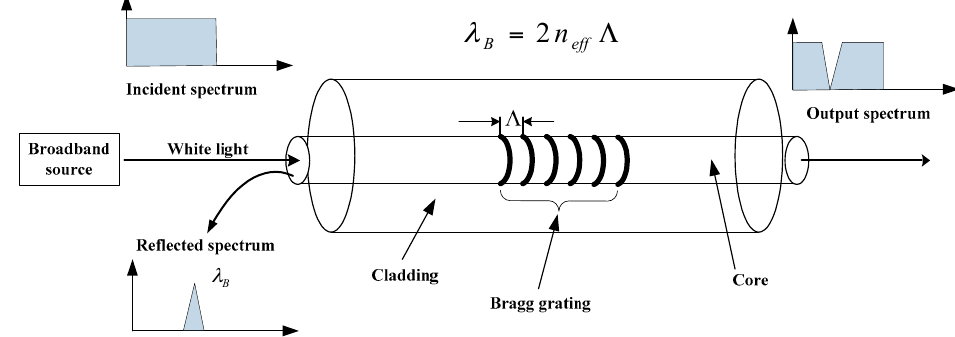
Figure 1. Measurement principle of FBG sensor.